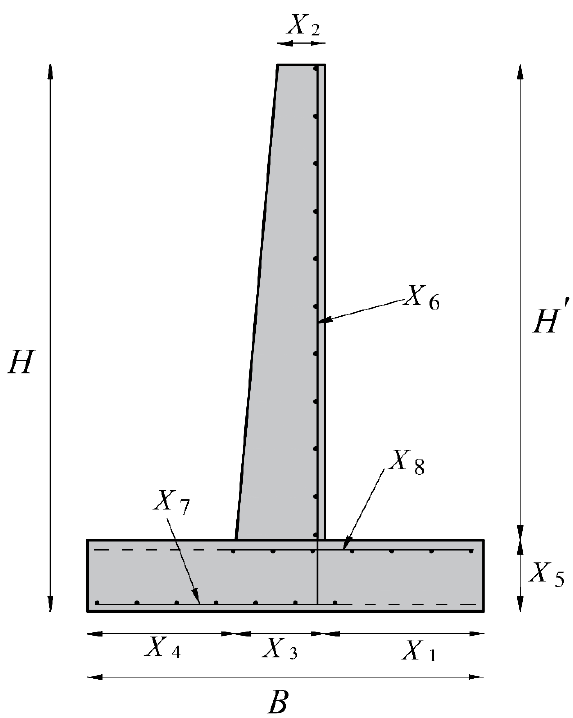
Figure 5. Design variables of the retaining structure.